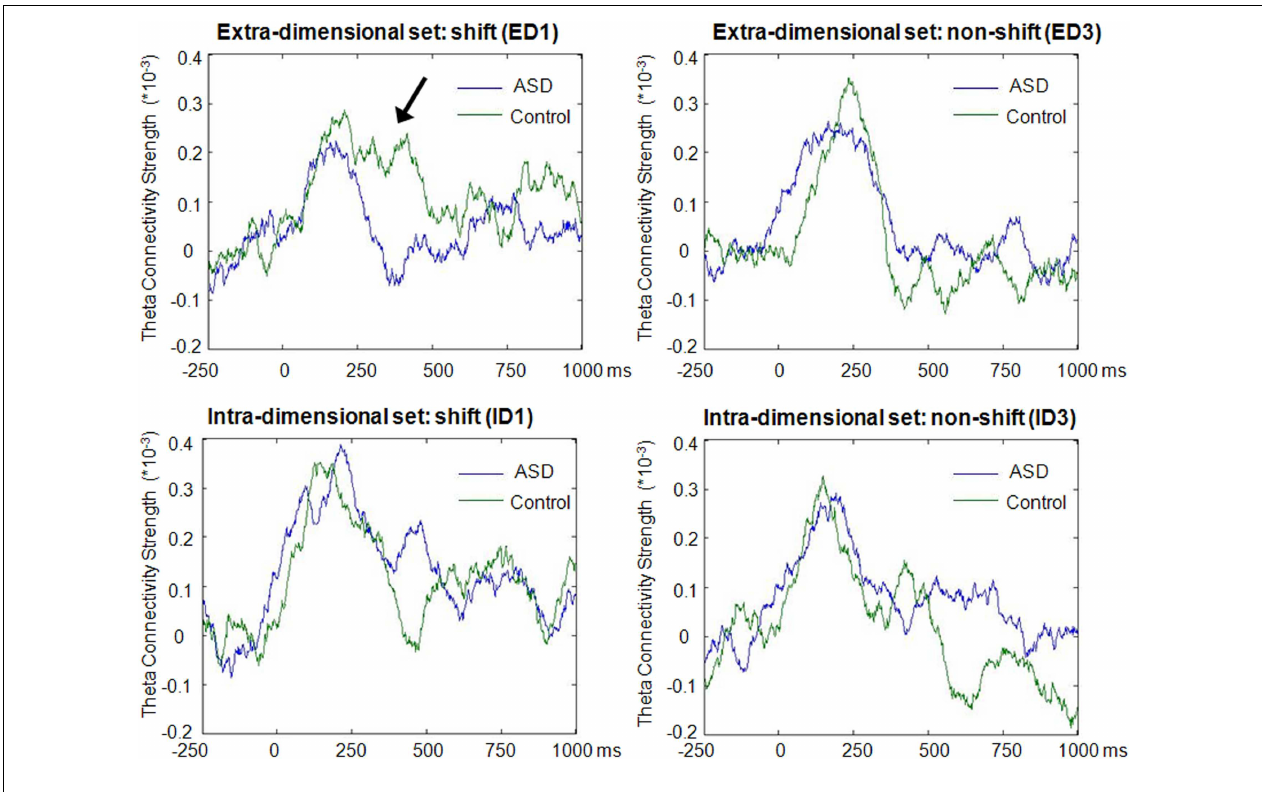
extradimensional (ED1) and intradimensional (ID1) sets, when increased engagement of executive functions was required, compared to the third trial of each set (ED3 and ID3) when set-shifting did not occur.These task-dependent modulations of network connectivity were observed for both groups, but reduced inter-regional theta connectivity was evident from 150 to 400ms during extradimensional set-shifting (ED1) in children with ASD